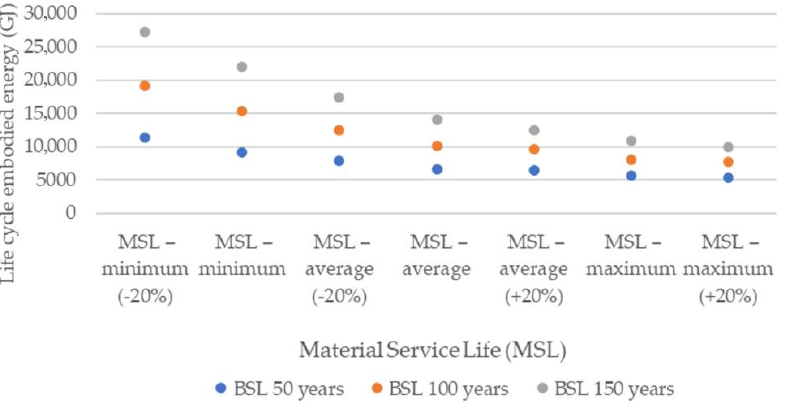
Figure 12. Life cycle embodied energy impact of BSL and MSL variations (50-year assessment period).